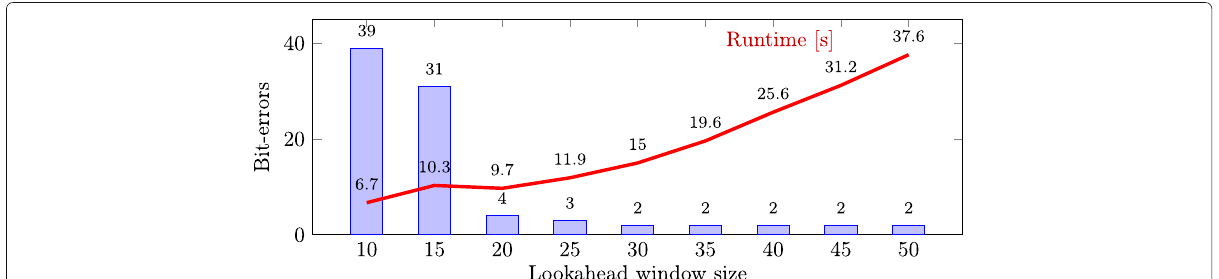
Fig. 10 Up to a lookahead window size of 30, an increased window size reduces the number of bit errors while increasing recovery runtime. The measurement is conducted with 7 traces